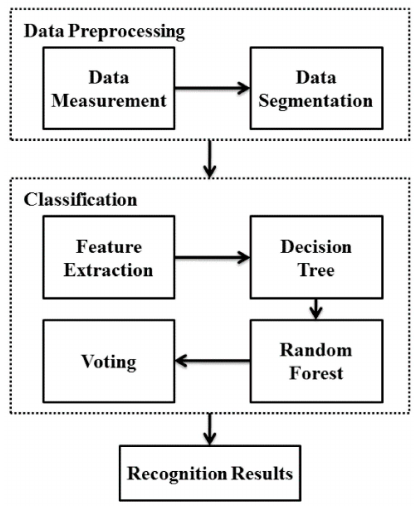
Figure 1. Structure of CSL subwords recognition framework based on random forest.